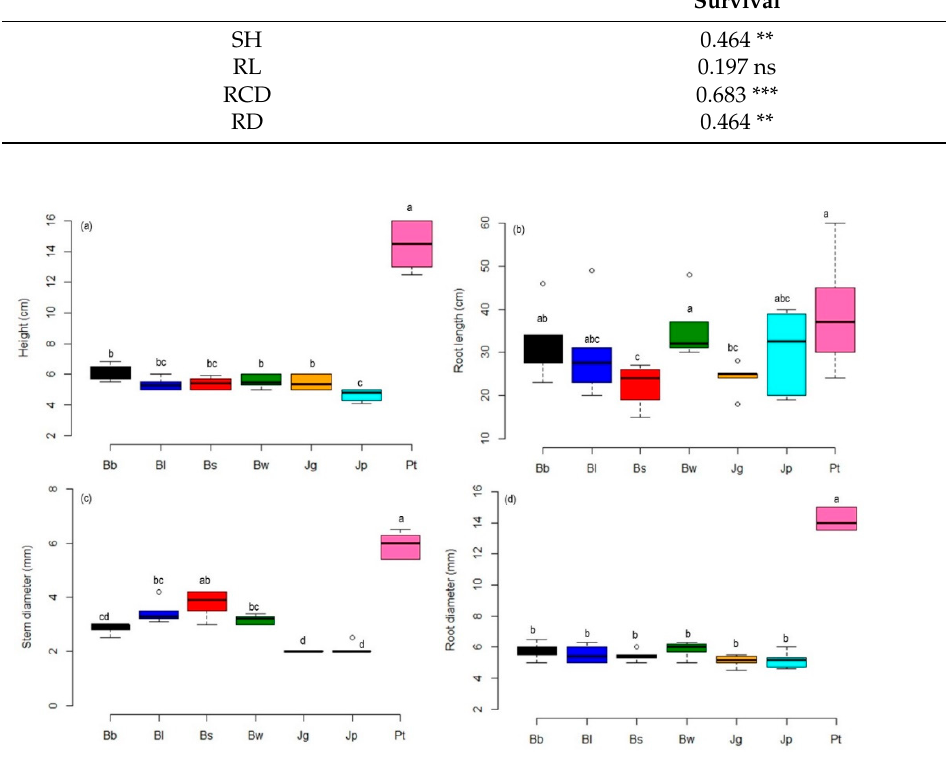
Figure A2. Growth of seedlings of 7 tree species from the woodland, 9 months after planting (September 2011). Bb: B. boehmii , Bl: B. longifolia , Bs: B. spiciformis , Bw: B. wangermeana , Jg: J. globiflora , Jp: J. paniculata and Pt: P. tinctorius . N = 3 replicates and 6 seedlings per replicate and per species.